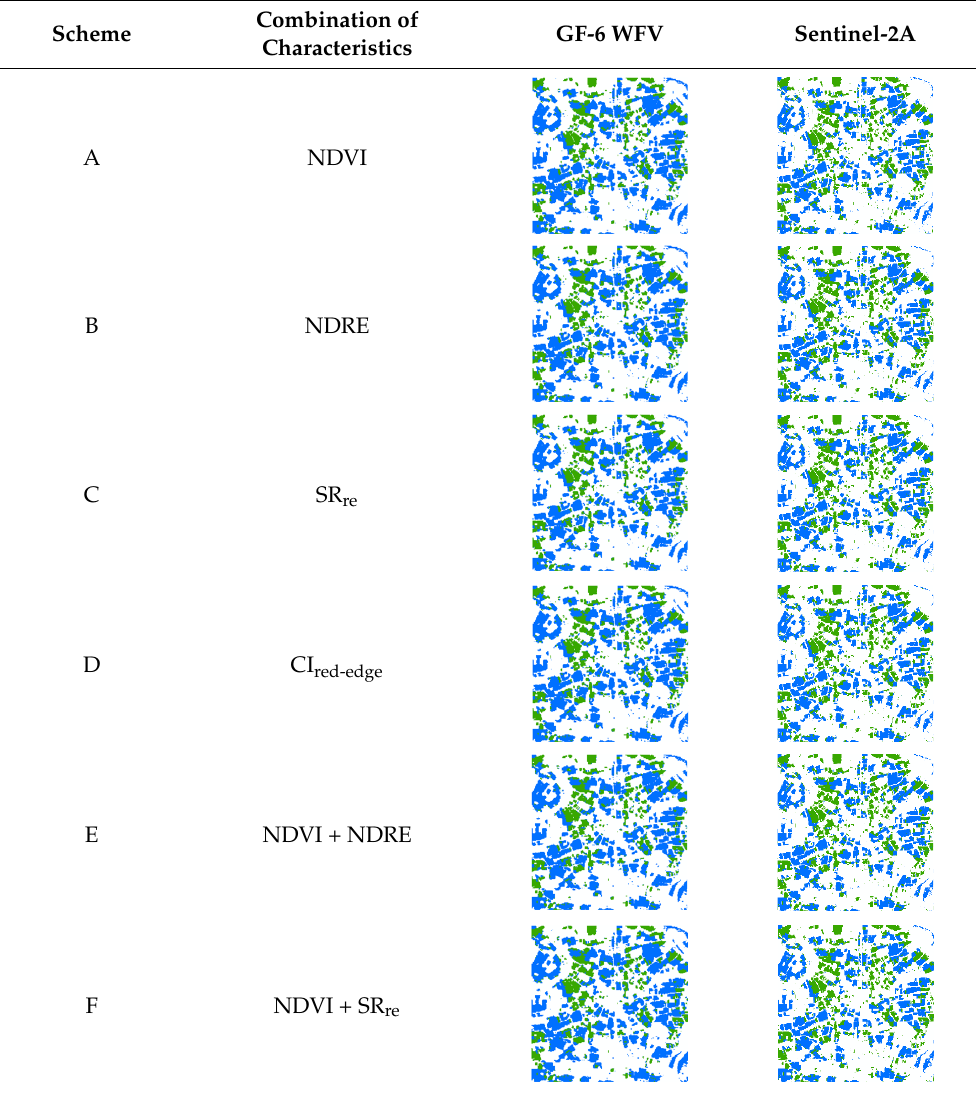
Table 9. Quantitative comparison of GF-6 WFV and Sentinel-2A data band sensitivities. Imagery